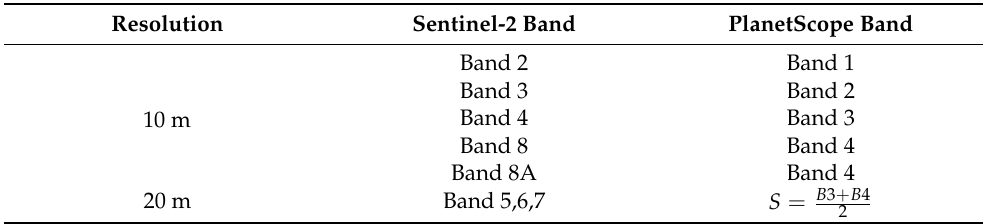
Table 3. Fusion pairs of Sentinel-2 and PlanetScope bands.